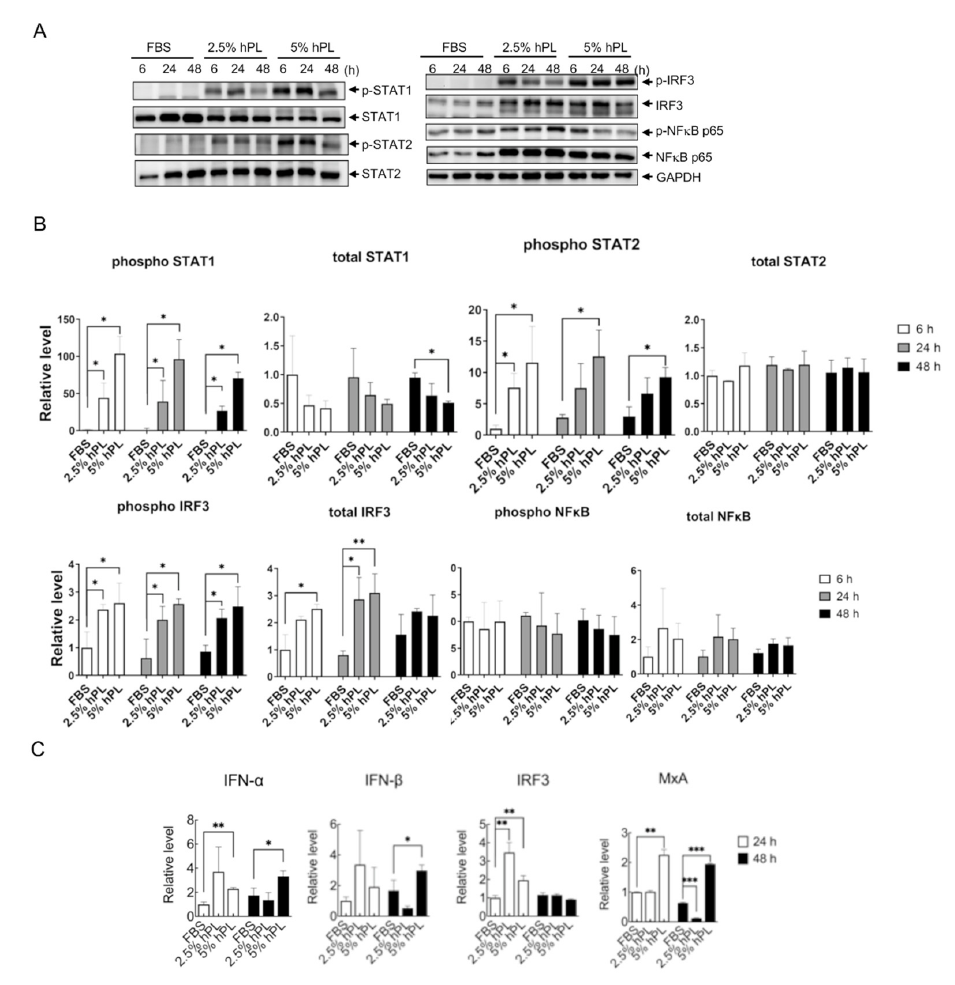
Figure 3. hPL-induced innate immunity response type I interferon and antiviral-related genes on GBM cells. ( A ) GBM cells were cultured under FBS, 2.5% and 5% hPL for 6 h, 24 h, and 48 h. The cell protein lysates were employed to analyze the innate immunity pathways by immunoblotting